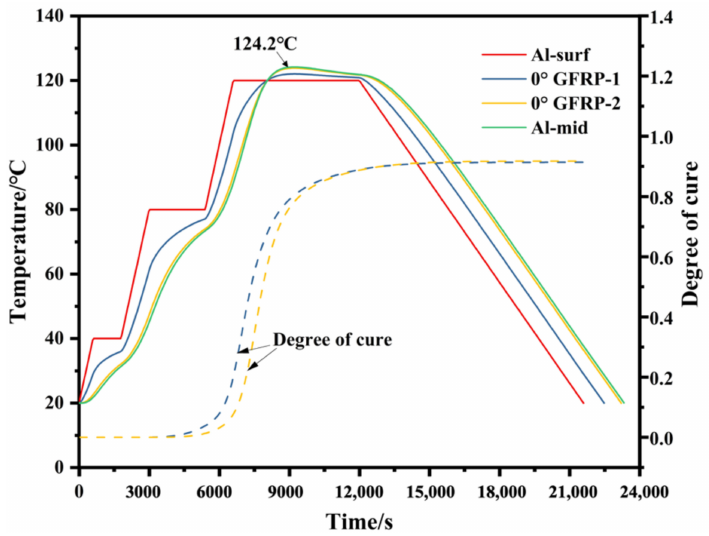
Figure 4. Simulated temperature and curing degree curves during the cure